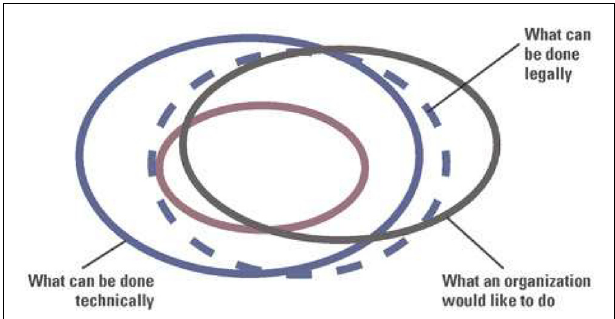
FIGURE 1 | Ethical boundaries of data analytics are shown as a sub-set of the legal boundaries of data analytics (Chalcraft, 2018, p. 19; Figure